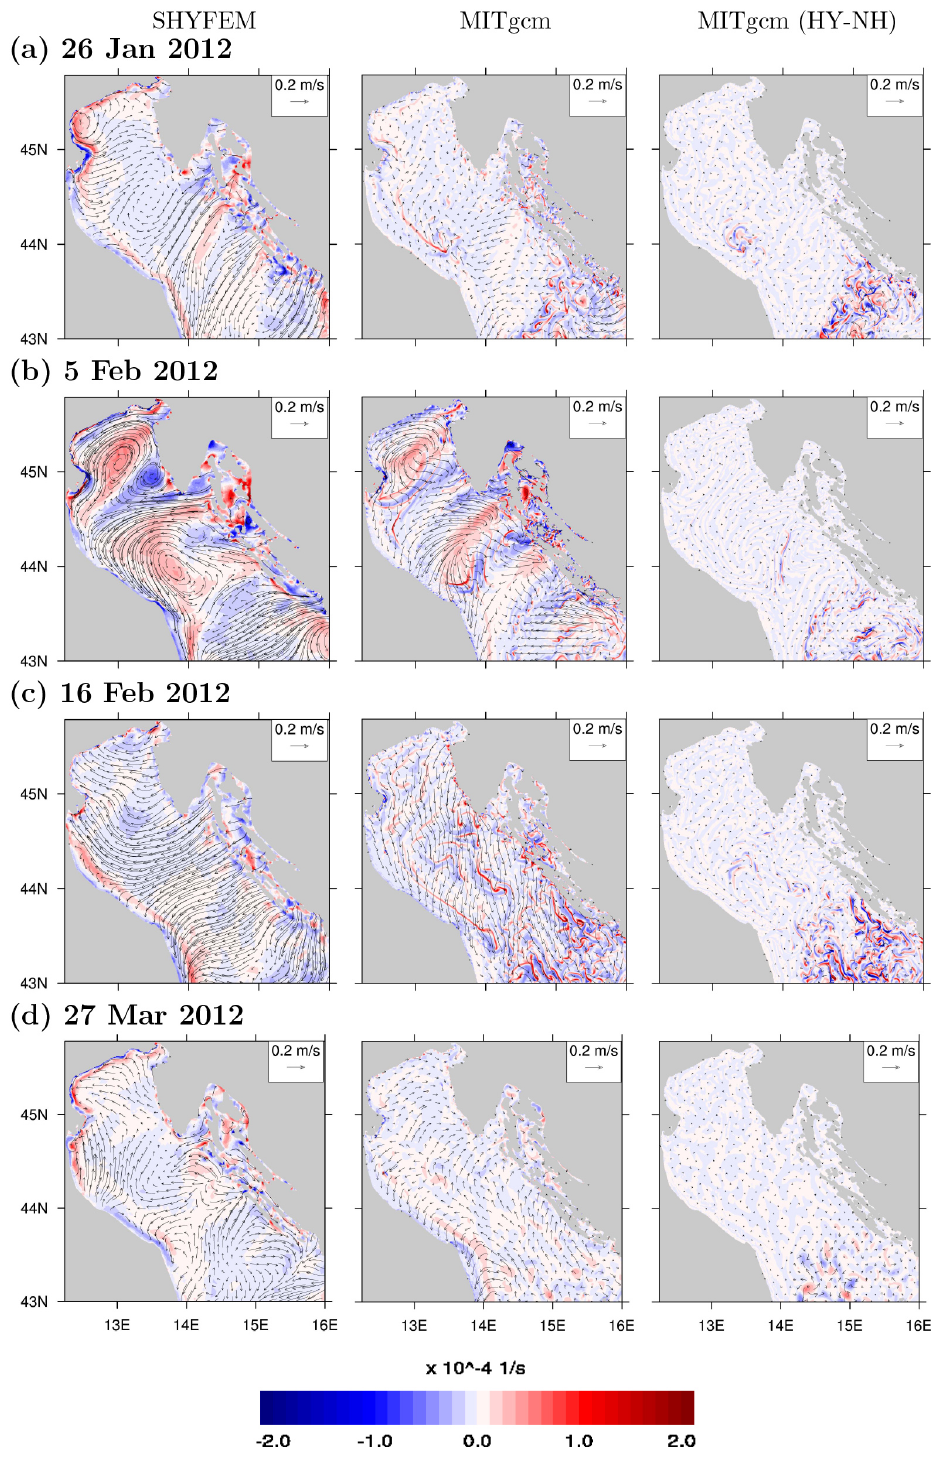
Figure 8. Maps of surface vorticity with surface current overlaid for SHYFEM (left panel) and MITgcm (central panel), in the hydrostatic implementation, and differences in vorticity between MITgcm hydrostatic and nonhydrostatic implementations (HY-NH, right panel), for the dates